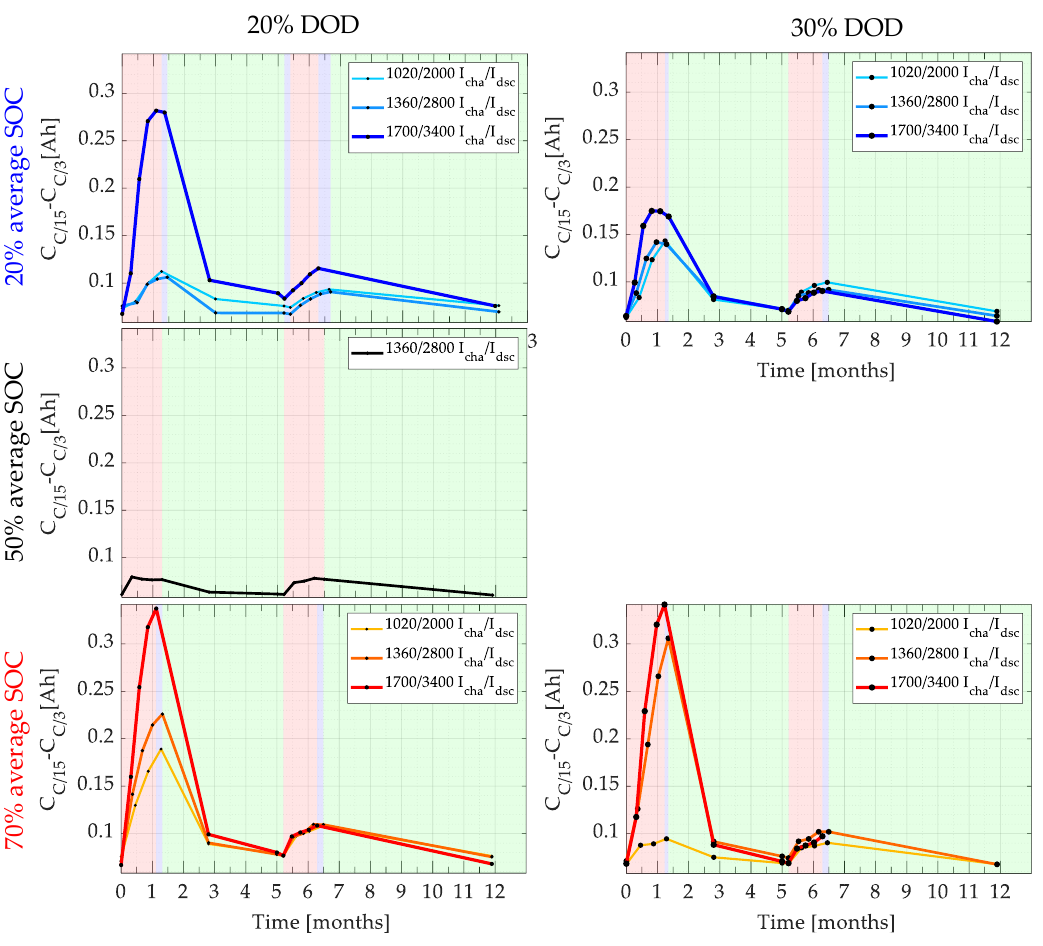
Figure 9. Capacity difference analysis (CDA) for cells cycled at 20%, 50%, and 70% average SOC with 20% and 30% DOD, and charge/discharge currents of 1020/2000, 1360/2800, and 1700/3400 mA.